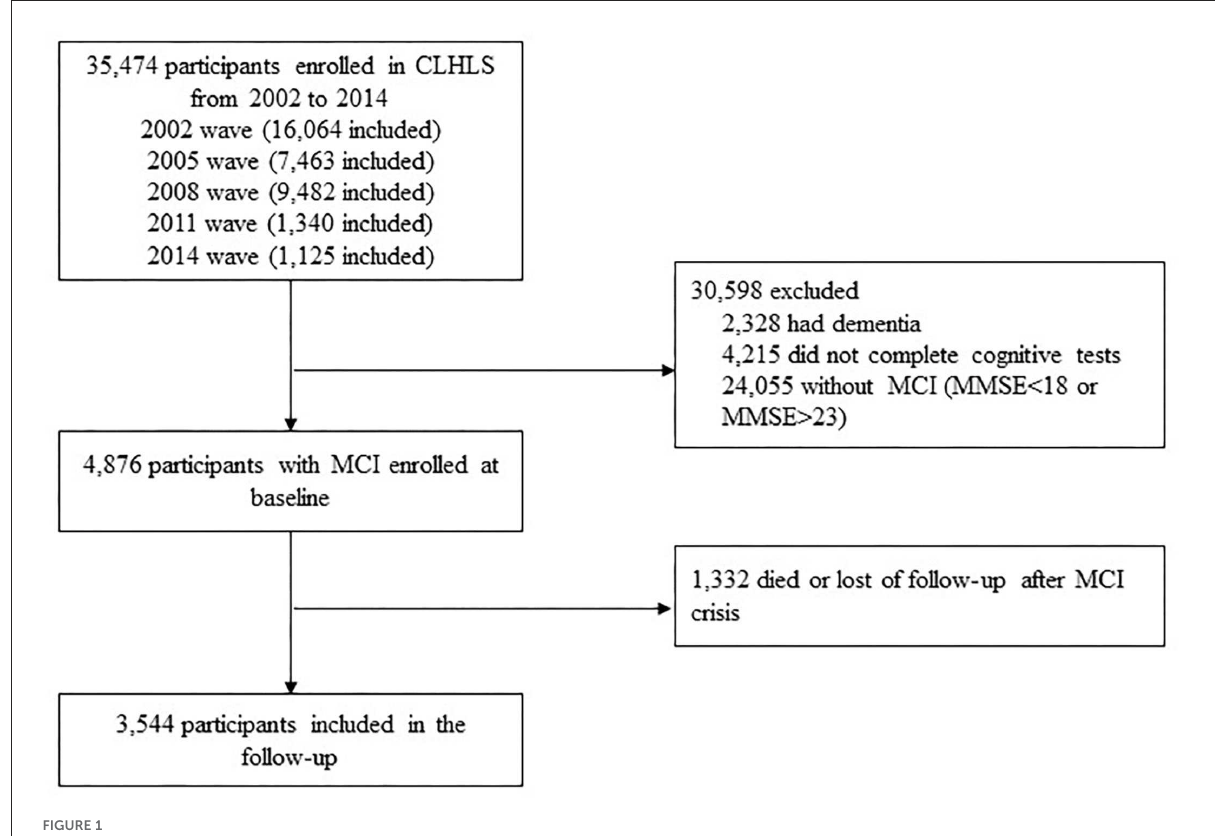
FIGURE1 Flow diagram of sample